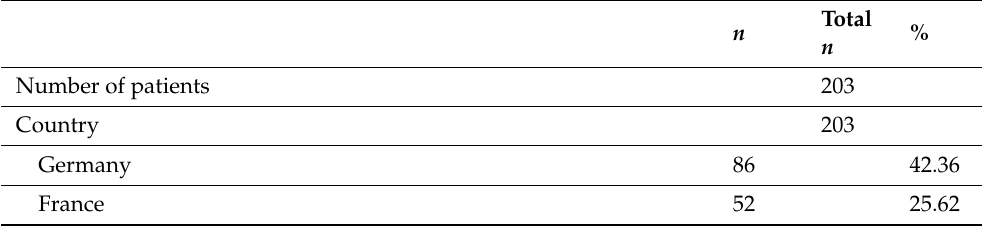
Table 1. General